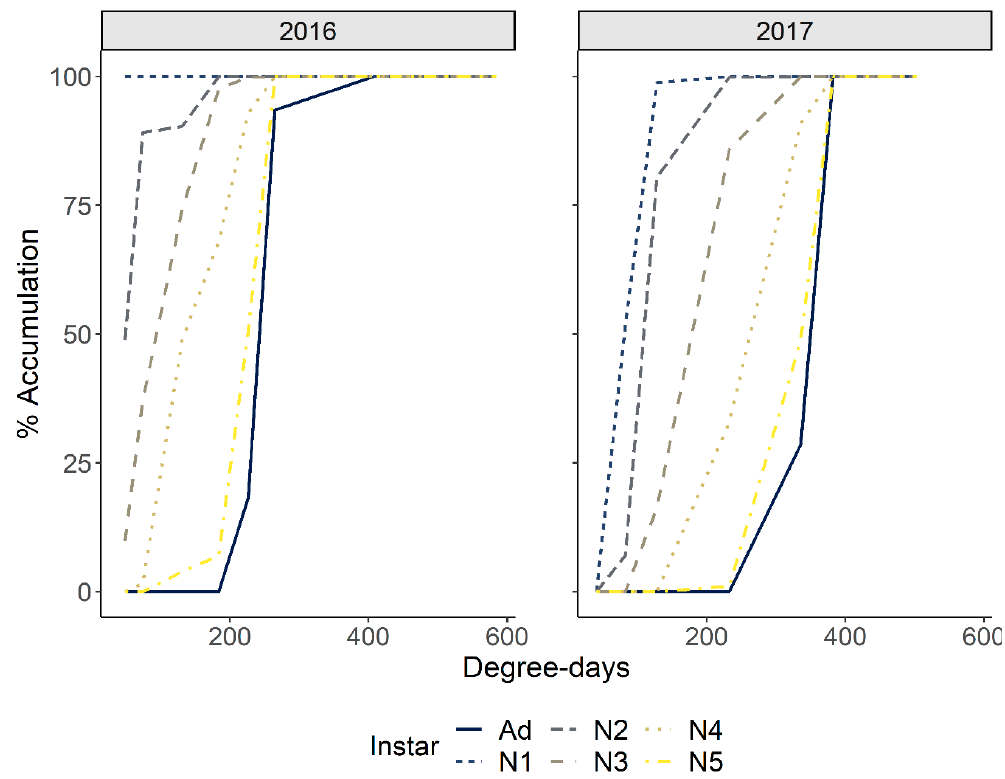
Figure 4. The observed cumulative population of the nymphal instars and newly emerged adults of Philaenus spumarius according to accumulated degree-days in the Asti (northwestern Italy) vineyard in 2016–2017.